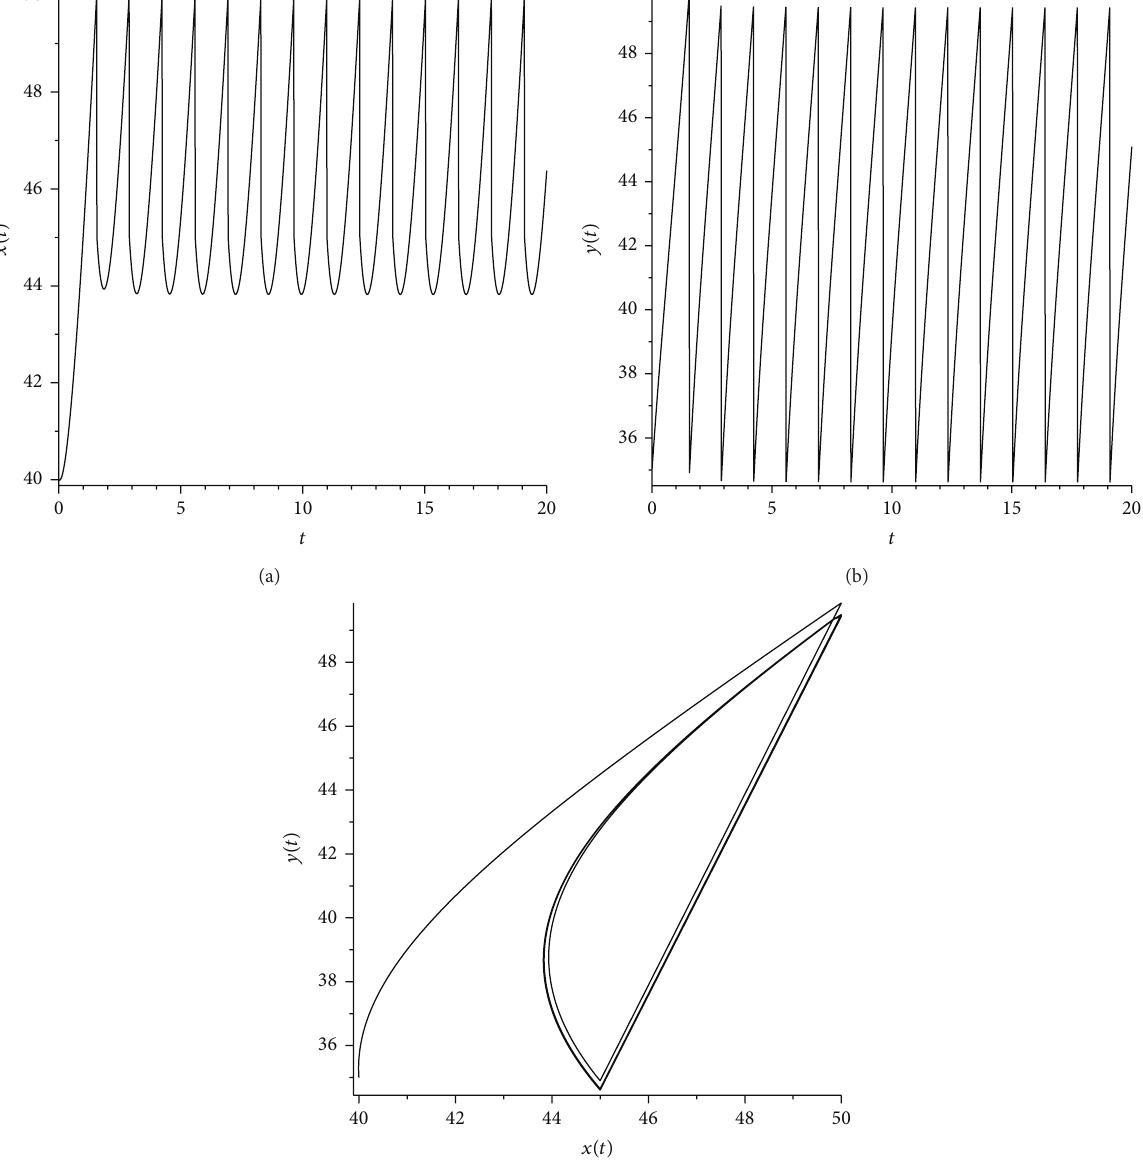
Changing 𝛼 = 0 . 8 , 𝑥 0 = 5 , 𝑦 0 = 40, the rest of the parameters are the same as Figure 12, and we obtain Figure